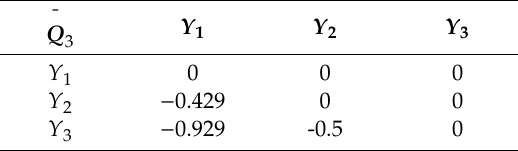
Table 12. The normalized regret matrix Q 3